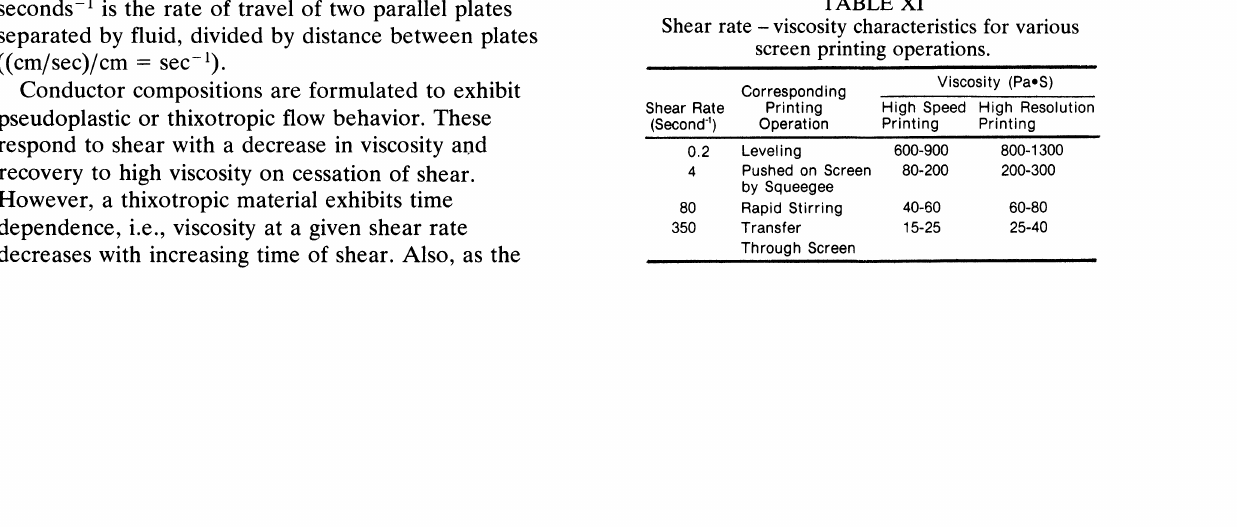
TABLE XI Shear rate- viscosity characteristics for various screen printing